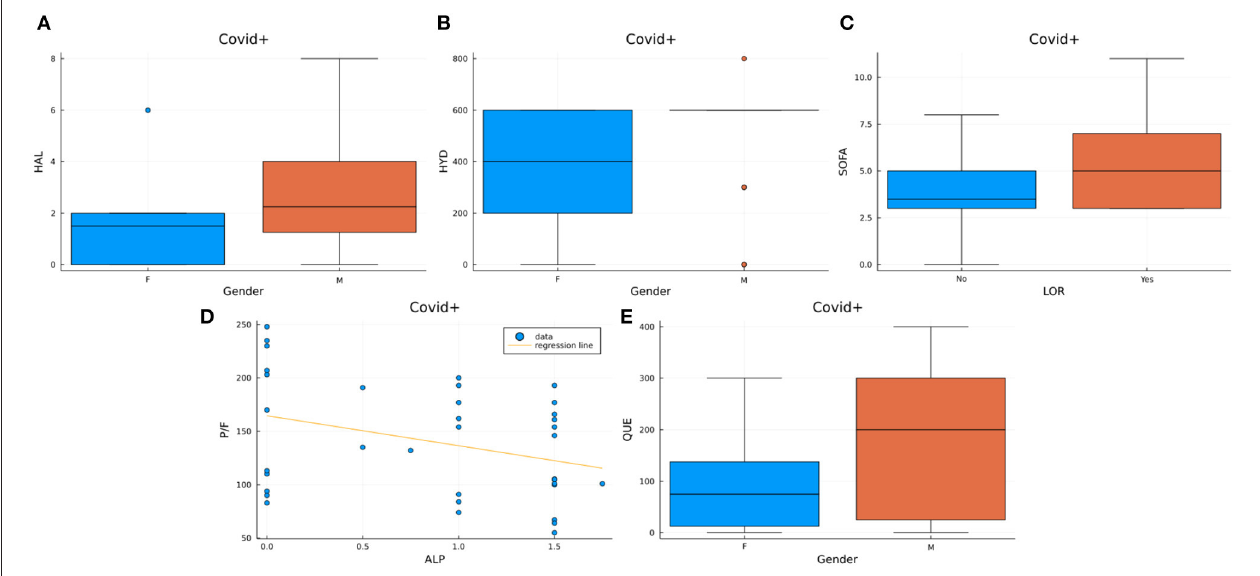
FIGURE 3 | Visualization of the significant results from the correlations in the COV + /DEL + group. Box plots represent the distribution of haloperidol ( Figure 2A ), quetiapine ( Figure 2E ) and hydroxyzine ( Figure 2B ) maximum dosages for each sex, SOFA scores in subjects assuming LOR vs. subjects not assuming LOR ( Figure 2C ). The scatter plot with regression line ( Figure 2D ) represents the distribution of P/F values vs. the maximum dose of alprazolam used. HAL, Haloperidol; HYD, Hydroxyzine; SOFA, Sepsis-related Organ Failure Assessment; P/F, PaO2/FIO2; QUE, Quetiapine; LOR, Lorazepam; ALP Alprazolam.